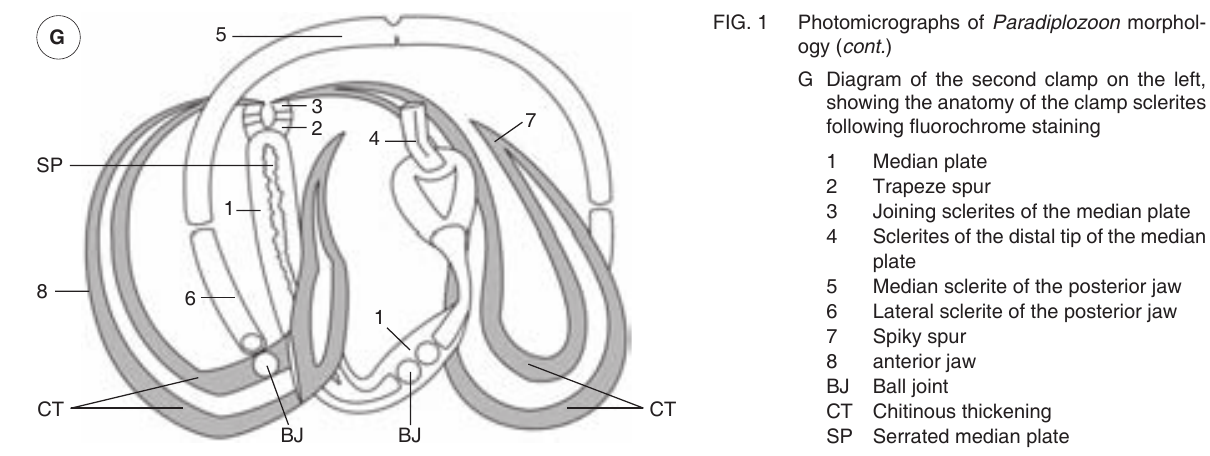
FIG. 1 Photomicrographs of Paradiplozoon morphol- ogy ( cont.